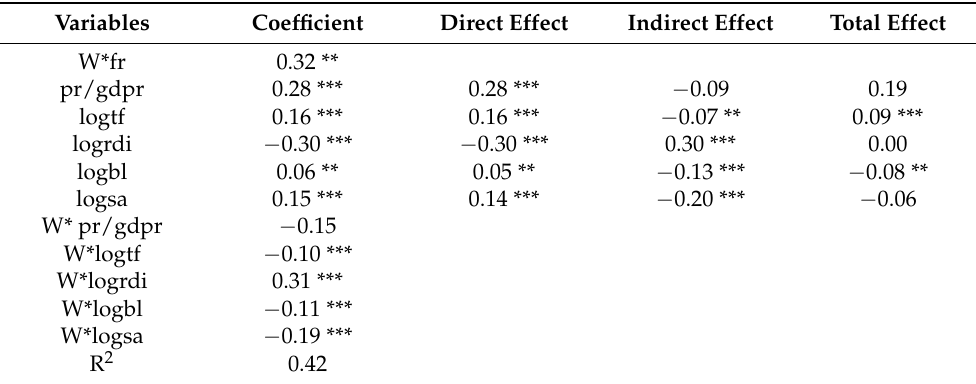
Table 5. Results of the SDM with spatial fixed effects for the 35 large and medium-sized cities in China. Variables Coefficient Direct Effect Indirect Effect Total Effect W*fr 0.32 ** pr/gdpr 0.28 *** 0.19